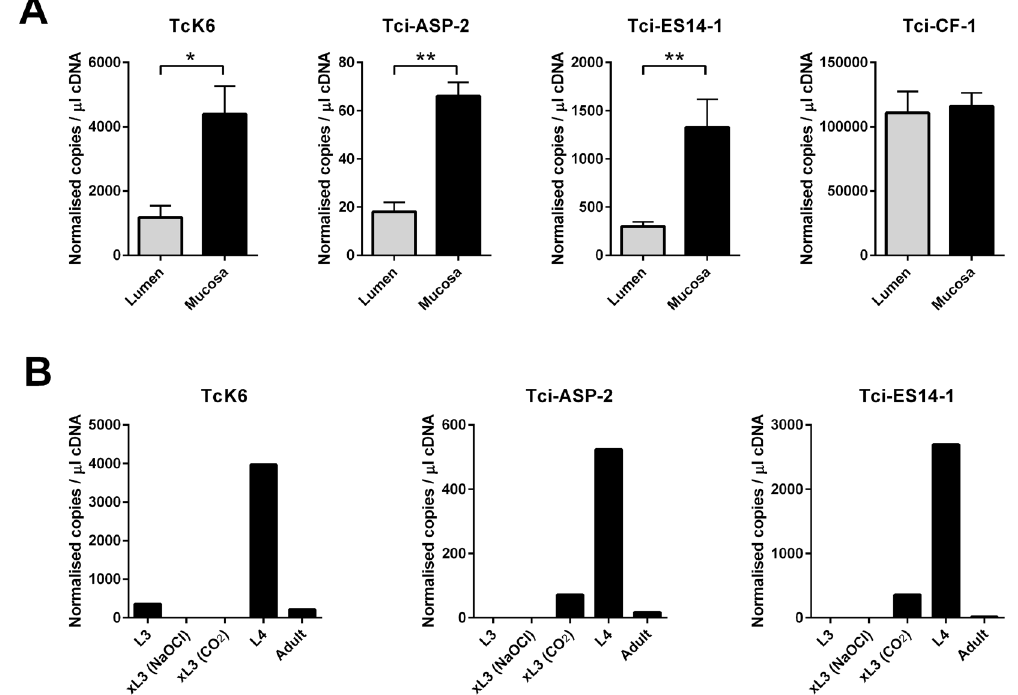
Figure 3. qPCR analysis of selected genes identified from RNA-Seq analysis. ( A ) qPCR validation of three differentially expressed transcripts (TcK6, Tci-ASP-2 and Tci-ES14-1) and one non-differentially expressed transcript (Tci-CF-1) identified through RNA-Seq analysis. ( B ) Stage specific transcription of TcK6, Tci-ASP-2 and Tci-ES14-1 as determined by qPCR. xL3 (NaOCl): T. circumcincta L3 larvae exsheathed following NaOCl treatment; xL3 (CO2): T. circumcincta L3 larvae exsheathed following treatment with CO 256 ; * = P < 0.05; ** P <